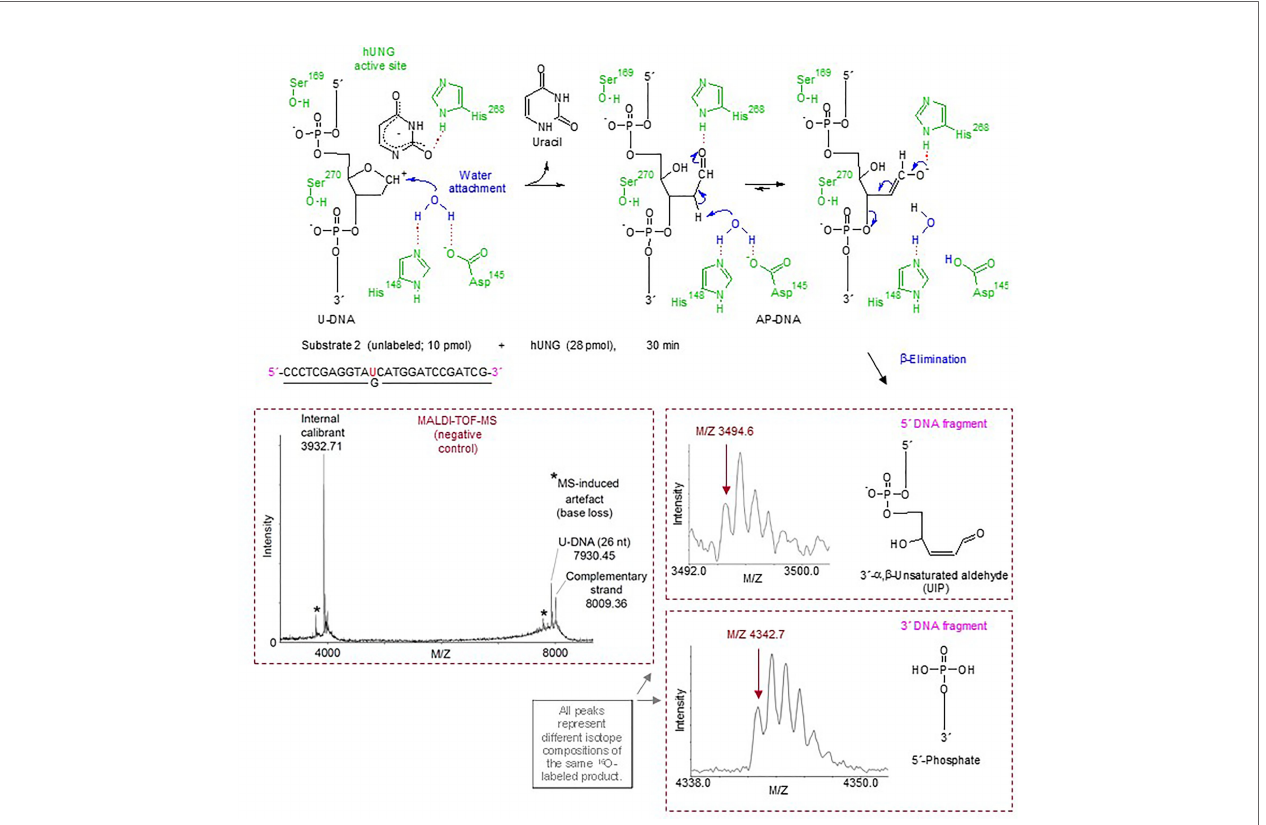
FIGURE 2 | Suggested hUNG reaction mechanism for incision of U-DNA into UIP and 5´-phosphate as identi fi ed by MALDI-TOF-MS and supported by structural modeling and site-directed mutagenesis. In the upper panel, amino acid residues of hUNG involved in catalysis are indicated in green; their hydrogen bonds with catalytic water and substrate are indicated by red dotted lines. Enzymatically activated H 2 O (in blue) is attached at C1´ of the abasic deoxyribose [blue arrow; based on refs. (49, 50)]. Proposed electronic (that cause atomic) transfers that are involved in the formation of UIP are indicated by short blue arrows. A hydrogen bond between His268 and the formyl oxygen of the ring-opened abasic deoxyribose (51) is proposed. We suggest that Asp145 acts as a general base, and that the attraction of electrons by the C1´ formyl group improves the C2´ hydrogen as a leaving group. The middle and lower right panels show the MALDI-TOF-MS signals of the 5´ and 3´ DNA incision fragments, respectively, while the middle left panel shows the signals obtained from incubation without